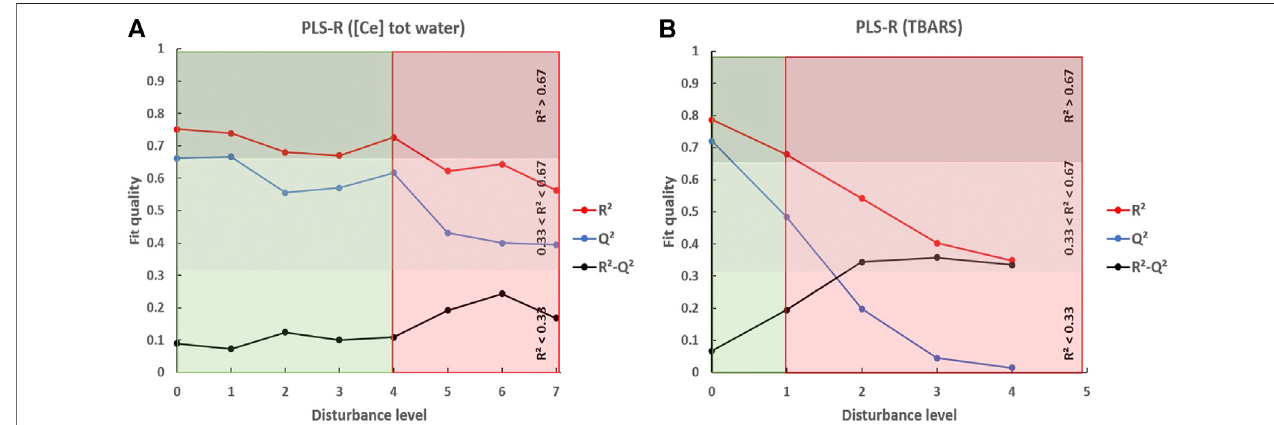
FIGURE3| Evolutionof R 2 and Q 2 infunctionofthepercentageofarti fi cialdatadisturbancefollowinglevelsprovidedin Table2 . (A) correspondstothemodelingof [Ce] tot water by PLS-R. (B) corresponds to the modeling of the TBARS by PLS-R. The red line represents the evolution of R 2 , the blue line represents the evolution of Q 2 , and theblacklinerepresentstheevolutionofthedifference R 2 − Q 2 .Level0meansnodisturbance ofthedataset.Thegreenzoneillustratesthelevelsofdisturbance that generate a great fi t quality, while the red zone illustrates the levels of disturbance generating poor fi t